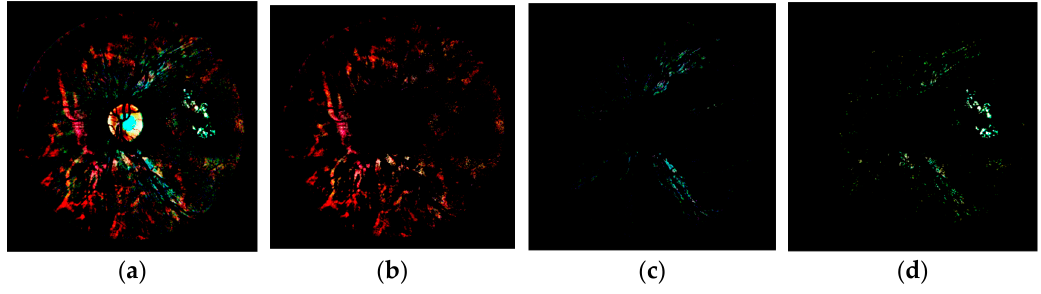
Figure 5. Exudate candidate segmentation. ( a ) Image I bri . ( b ) Image L chor − bri . ( c ) Image L bm . ( d ) Image L ex − cand . These images are shown with enhanced contrast for an easier readability.